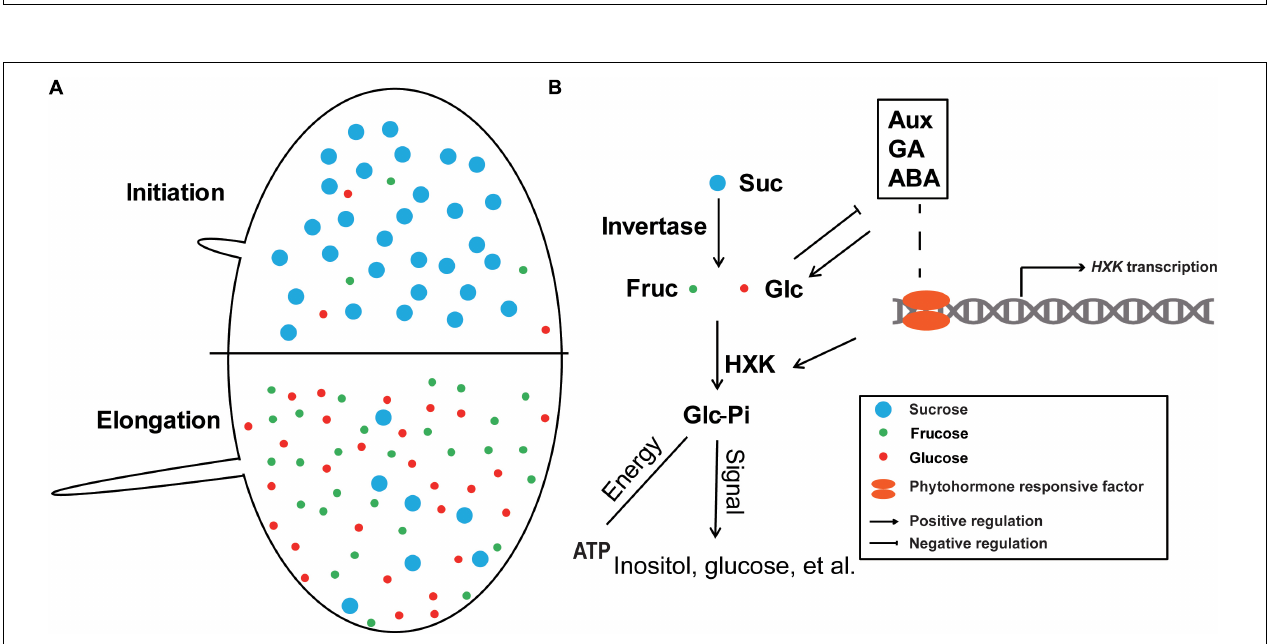
FIGURE 11 | A hypothesis about the roles of GhHXKs in cotton fiber development. (A) During fiber developmental stages, from initiation to elongation, the sucrose content decreased, and the fructose and glucose content increased. (B) The phosphorylated hexose functions in energy supply and signal transduction in fiber development; Meanwhile, intracellular hexose levels are regulated by IAA, GA, and ABA, and GhHXK is the center of this pathway. The blue, red and green dots represent sucrose, glucose and fructose, respectively. The arrows and blunt arrows indicate positive and negative regulation of the specific processes, respectively.